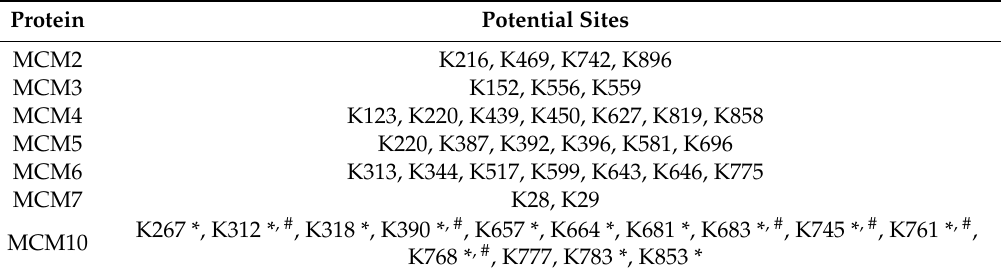
Table 7. MCM acetylation in human cancer cells.